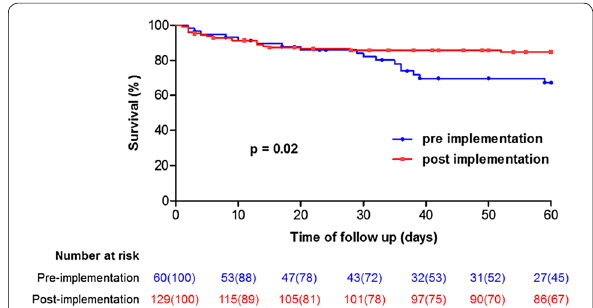
Fig. 2 Kaplan–Meier survival curves comparing patients admitted during the pre‑ (blue line) and post‑ (red line) bundle of care implementation periods. p value comes from an unadjusted log rank test. Survival was censored at 60